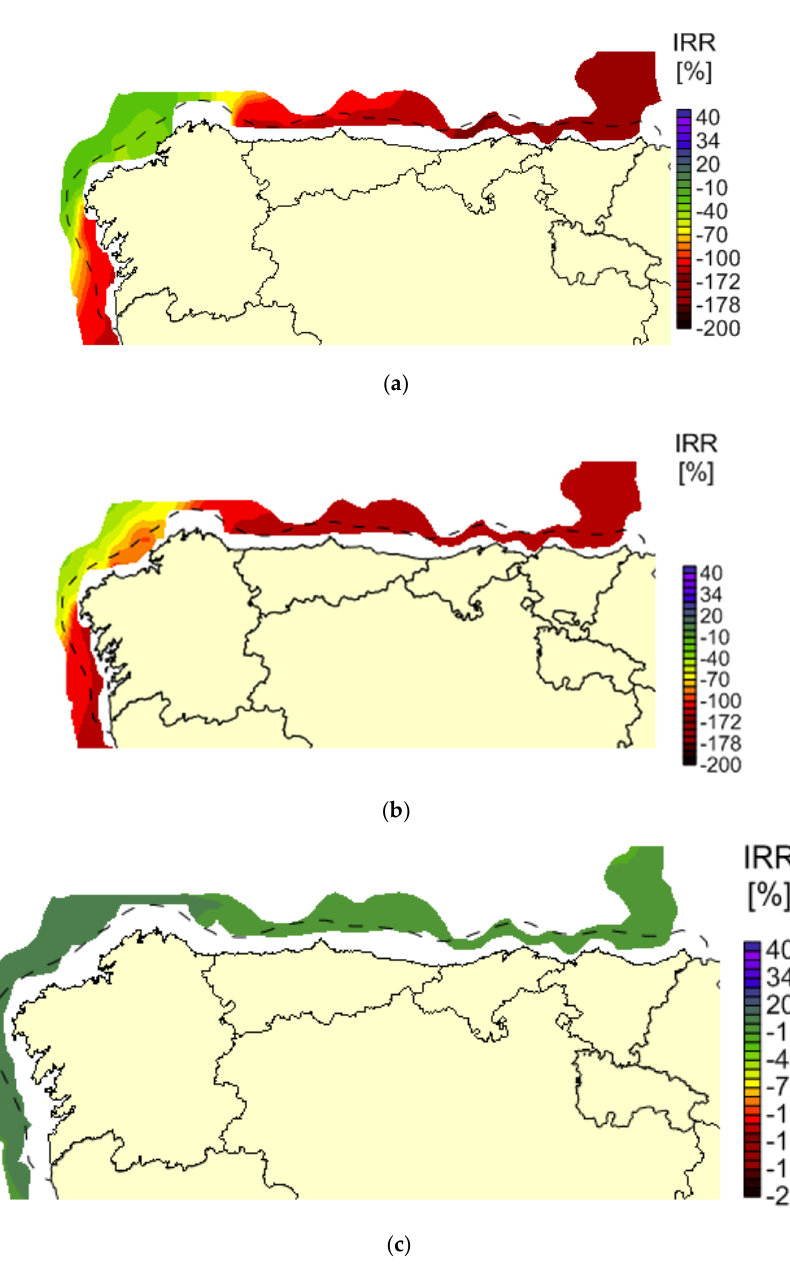
Figure 12. Internal rate of return contemplating a 600 €/MWh tariff and a depth restriction for D1 ( a ), D2 ( b ) and D3 ( c ).